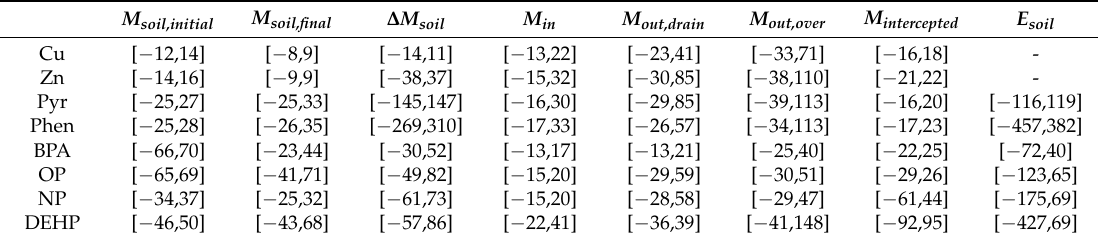
Table A10. Relative uncertainties (95% confidence interval) for all terms micropollutants, in percentage. M soil,initial M